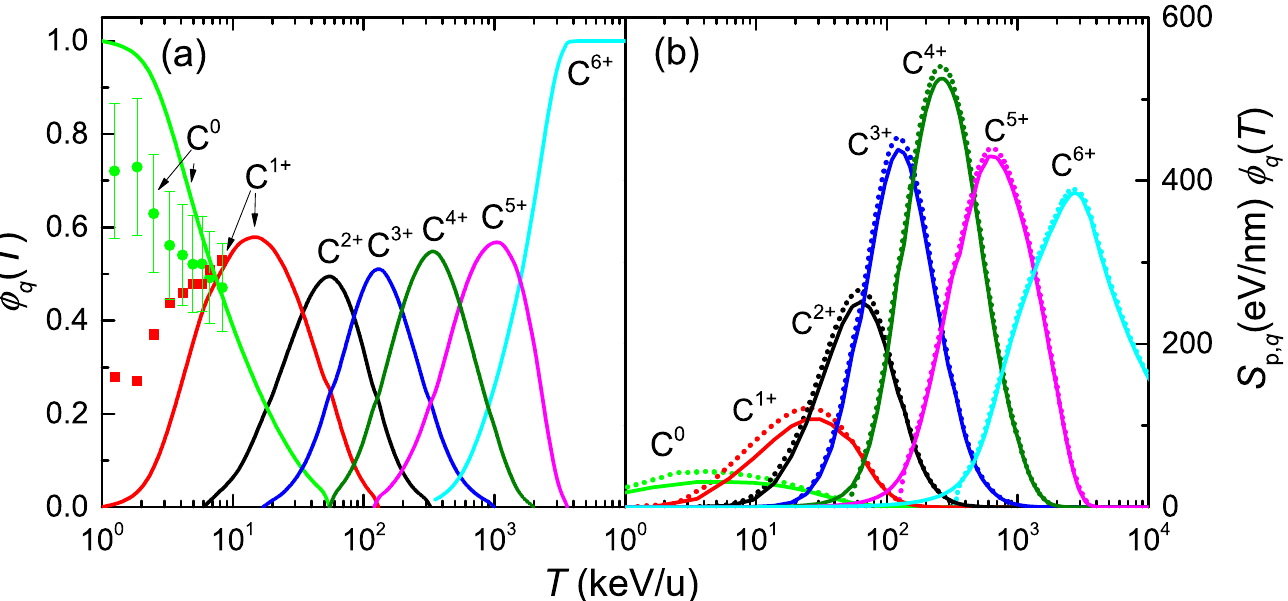
Figure 2. ( a ) Equilibrium charge state fractions, φ q ( T ) , of carbon ions in water, as a function of the incident energy T . Solid lines come from the parameterisation from Ref. [95] and Bragg’s rule, whereas symbols correspond to experimental data from [94]. ( b ) Stopping power multiplied by the equilibrium charge fraction, S p, q ( T ) φ q ( T ) , for each charge state of carbon in liquid water, as a function of the incident energy. Solid (dotted) lines correspond to the LR-TDDFT (MELF-GOS) approach for the